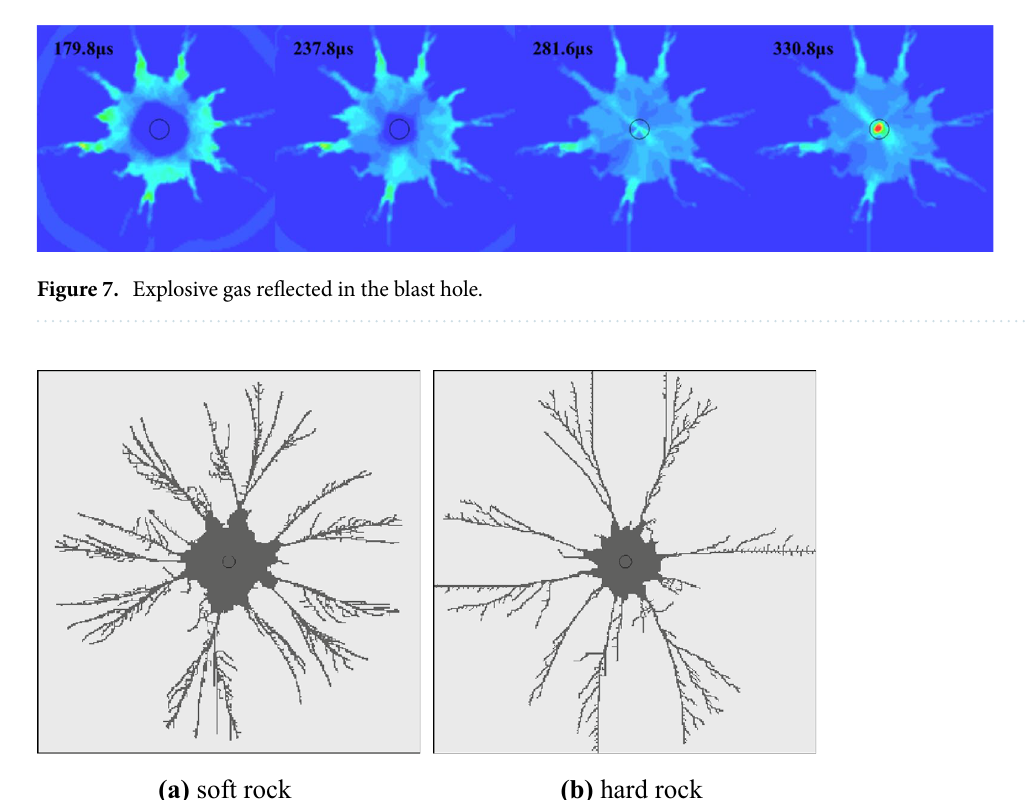
Figure 8. Simulation results of burst cracks.